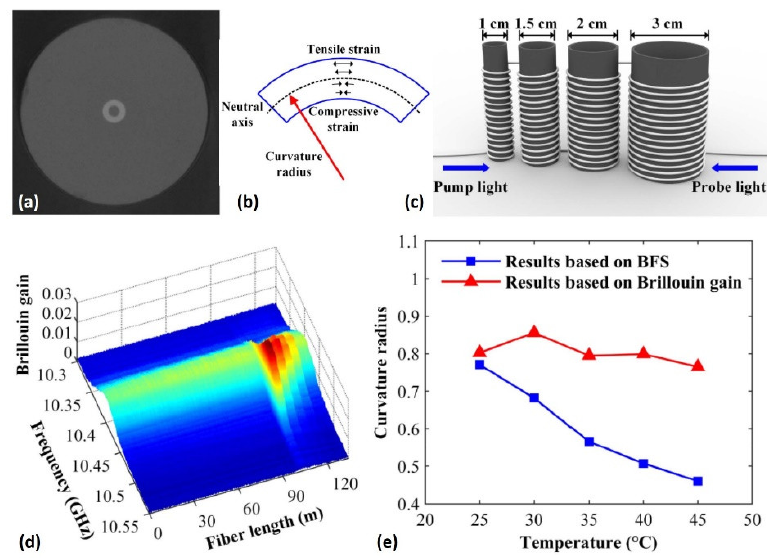
Figure 9. ( a ) Optical microscope image of the cross section of an RCF, ( b ) schematic illustration of strain applied in a bent fiber, ( c ) illustration of distributed curvature measurements by winding the RCF around different rod diameters, ( d ) measured Brillouin gain along the RCF including four sections where the RCF is winded. ( e ) Estimation of the curvature from BFS or Brillouin gain measurements versus temperature variations. Reproduced from [54], with the permission of Chinese Laser Press Publishing.